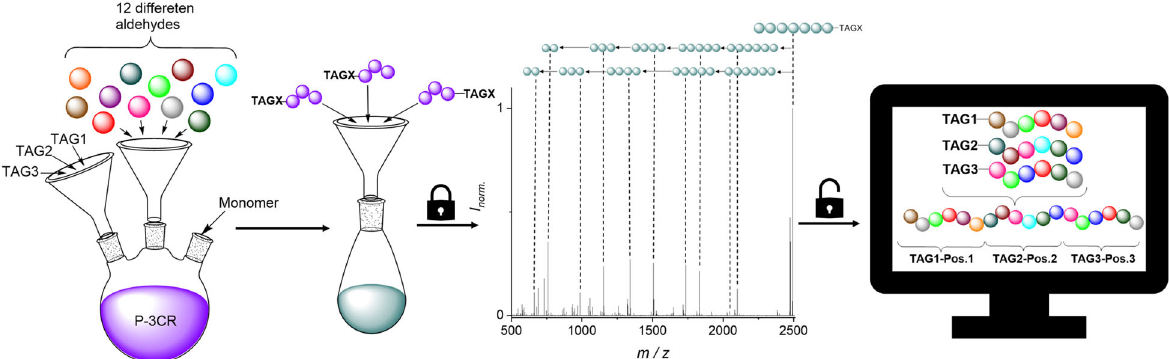
Fig. 1 Concept of the automated read-out of a mixture of sequence-de fi ned molecules by varying 12 different aldehydes and speci fi cally designed mass markers (TAGs). Iterative step synthesis with the Passerini three component reaction (P-3CR), using twelve different aldehydes and three different TAGs. The aldehydes can be introduced at any desired position of the oligomer and provide the sidechains of the macromolecule and thus differentiate each repeating unit. Subsequently, the individual sequences of an oligomer mixture can be analyzed via ESI-MS and ESI-MS/MS, followed by fully automated read-out with the computer program with a clearly de fi ned position of